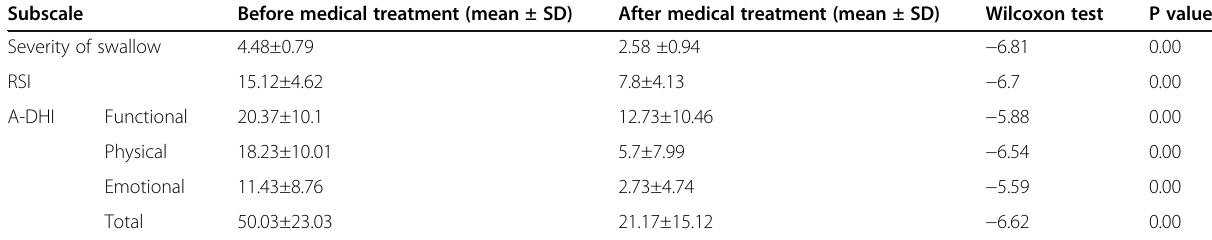
Table 5 Severity of swallow, RSI, and A-DHI questionnaire scores before and after medical treatment among the participants Subscale Before medical treatment (mean ± SD)